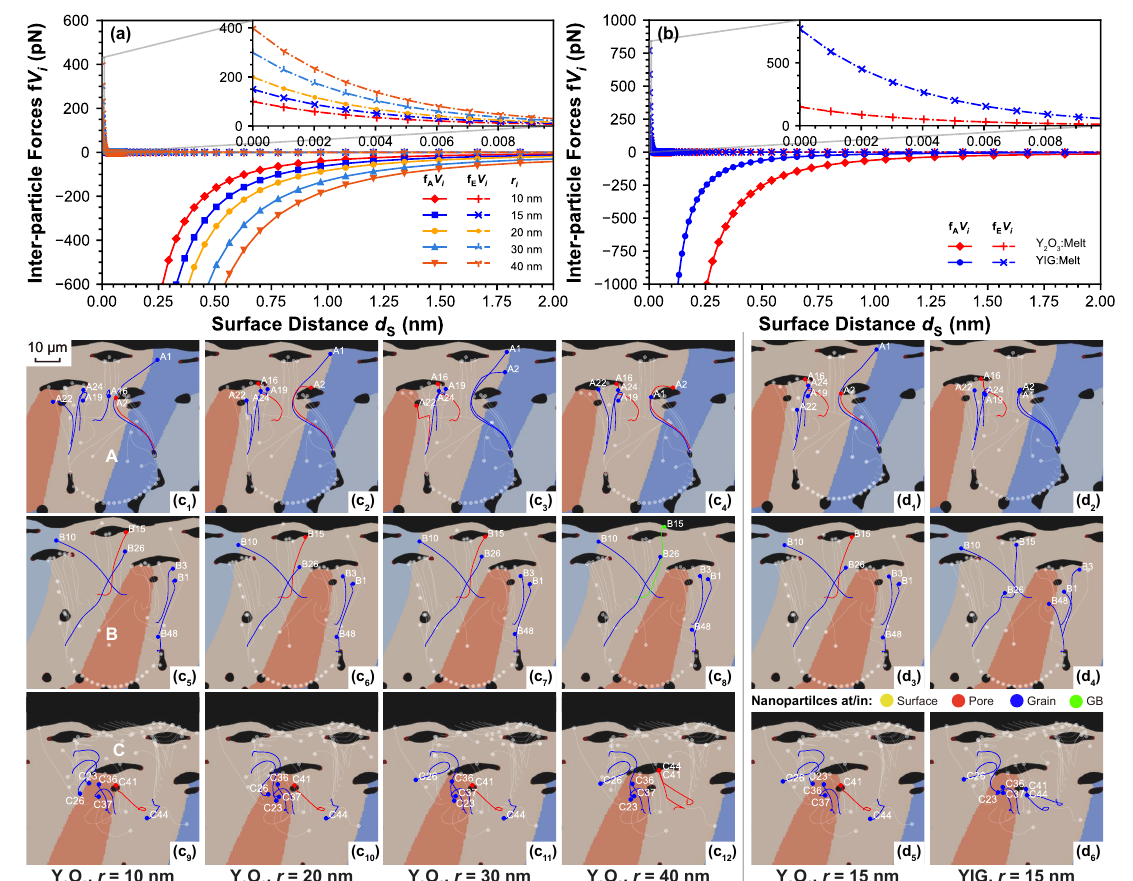
Figure 4. Diagrams of interactive forces between two nanoparticles of the same size vs. surface distance for cases ( a ) varying size (radius) for two Y 2 O 3 nanoparticles, and ( b ) comparing nanoparticle compositions of Y 2 O 3 and YIG for two nanoparticles with ri = 15 nm. Trajectories and relative positions at the final timestep are respectively for nanoparticles with varying radius and composition on different parent particle, i.e., for Y 2 O 3 nanoparticles on parent particle A with varying radius of ( c 1 ) 10 nm, ( c 2 ) 20 nm, ( c 3 ) 30 nm, ( c 4 ) 40 nm; on parent particle B with radius of ( c 5 ) 10 nm, ( c 6 ) 20 nm, ( c 7 ) 30 nm, ( c 8 ) 40 nm; on parent particle C with radius of ( c 9 ) 10 nm, ( c 10 ) 20 nm, ( c 11 ) 30 nm, ( c 12 ) 40 nm; and for nanoparticles with monomodal radius of 15 nm on parent particle A with composition ( d 1 ) Y 2 O 3 , ( d 2 ) YIG; on parent particle B with composition ( d 3 ) Y 2 O 3 , ( d 4 ) YIG; on parent particle C with composition ( d 5 ) Y 2 O 3 , ( d 6 ) YIG. it demonstrates that the pattern of trajectories changes due to varying size/composition. By comparing the selected trajectories (labeled uniformly), an enhanced nanoparticle floating is observed when increasing the size of